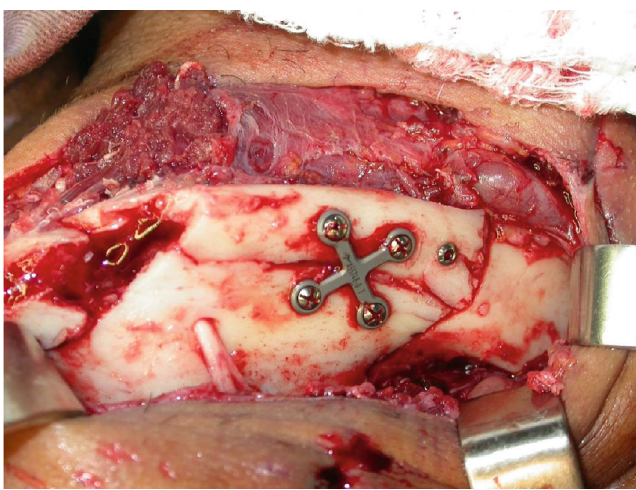
Figure 8: Reduction and stabilization of fractures with the lag screw, X-plate, and 2.0 system titanium screws.